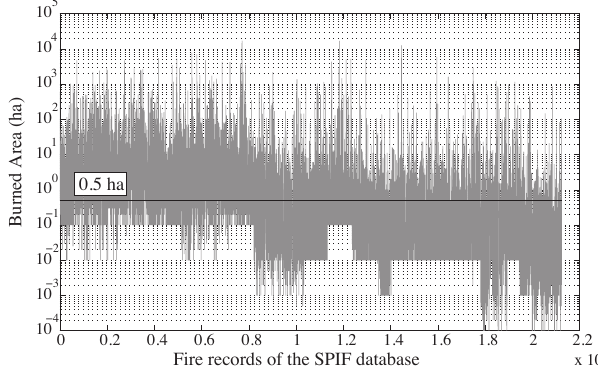
Fig. 2. Burned area (BA) in each record of the SPIF database in chronological order (BA in logarithmic scale, log 10